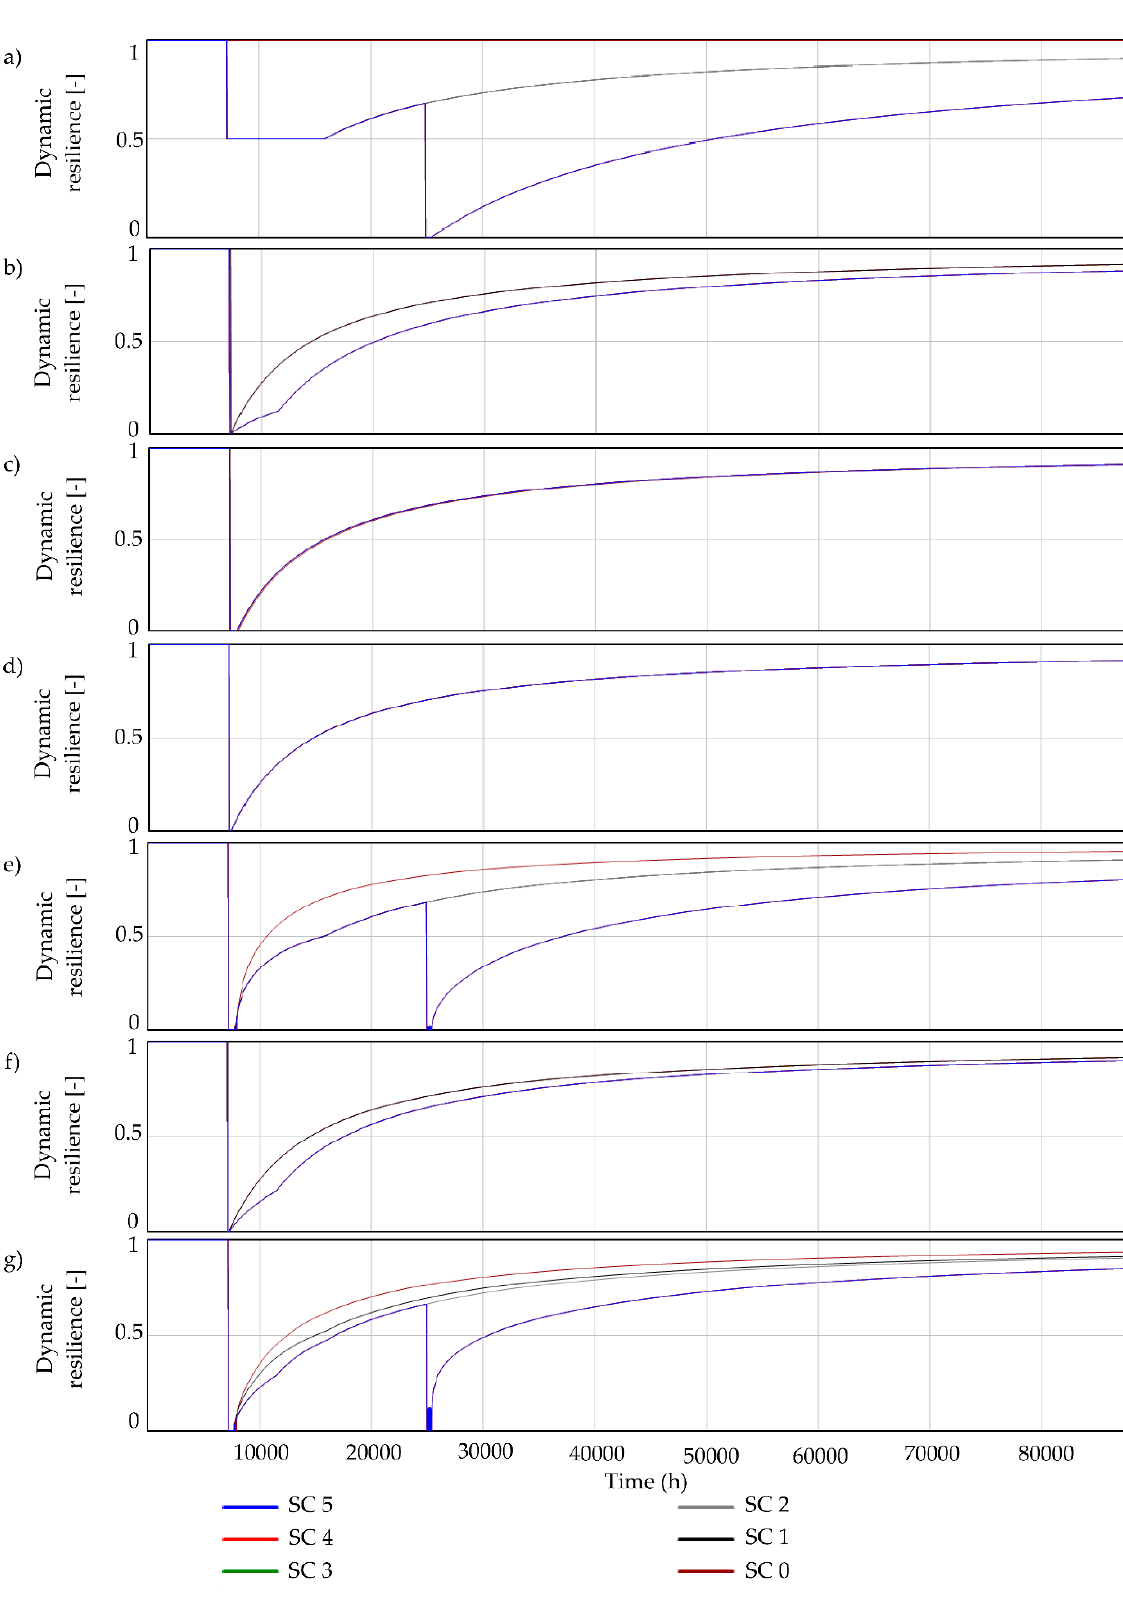
Figure 7. Dynamic resilience assessment of the Pirot reservoir system: ( a ) Reservoir HPP resilience; ( b ) Reservoir flood resilience; ( c ) River HPP resilience; ( d ) River flood resilience; ( e ) parameter HPP resilience; ( f ) parameter flood resilience; ( g ) multi-parameter resilience.